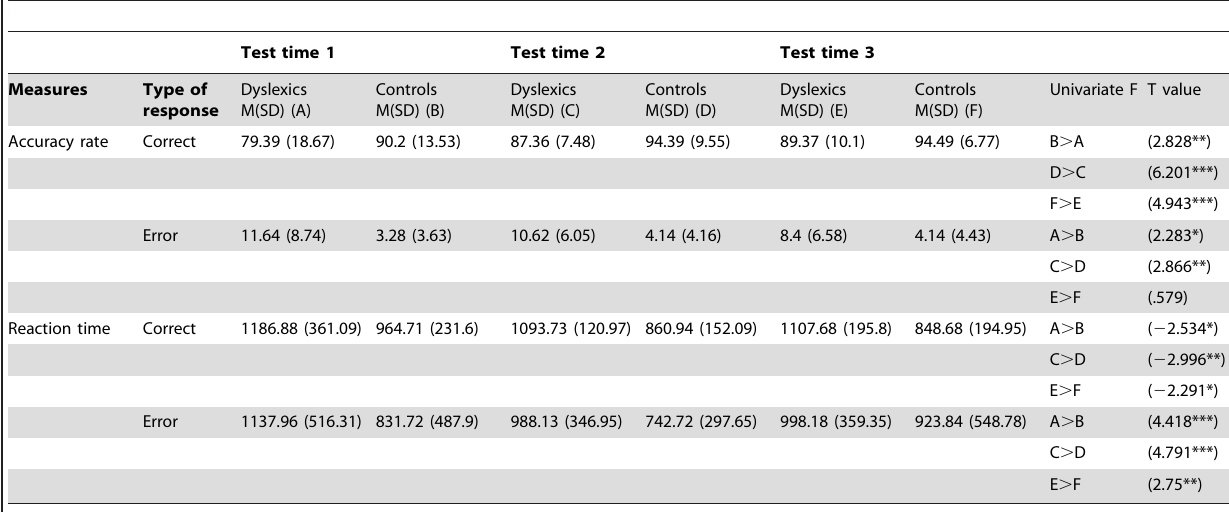
Table 4. Accuracy rate and reaction times for the experimental measures.